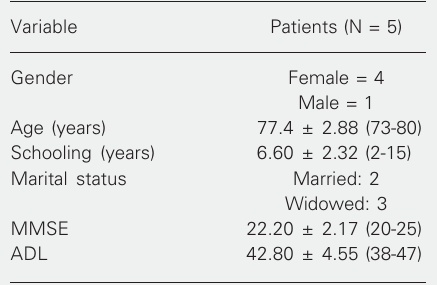
Table 1. Clinical and sociodemographic character- istics of patients with Alzheimer´s disease before cognitive